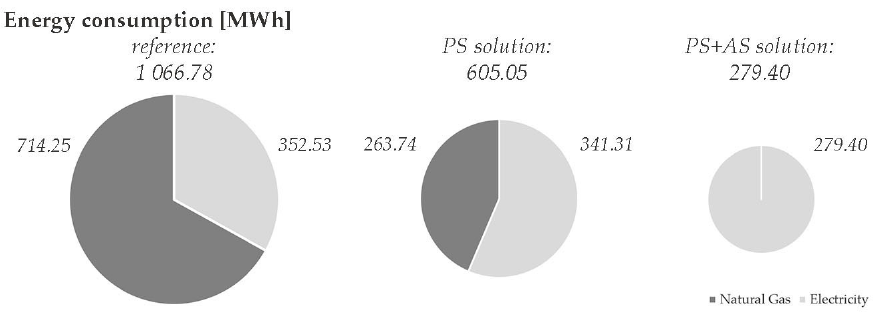
Figure 6. Comparison of the reference building, the optimal PS solution, and the PS+AS solution with respect to energy consumption.